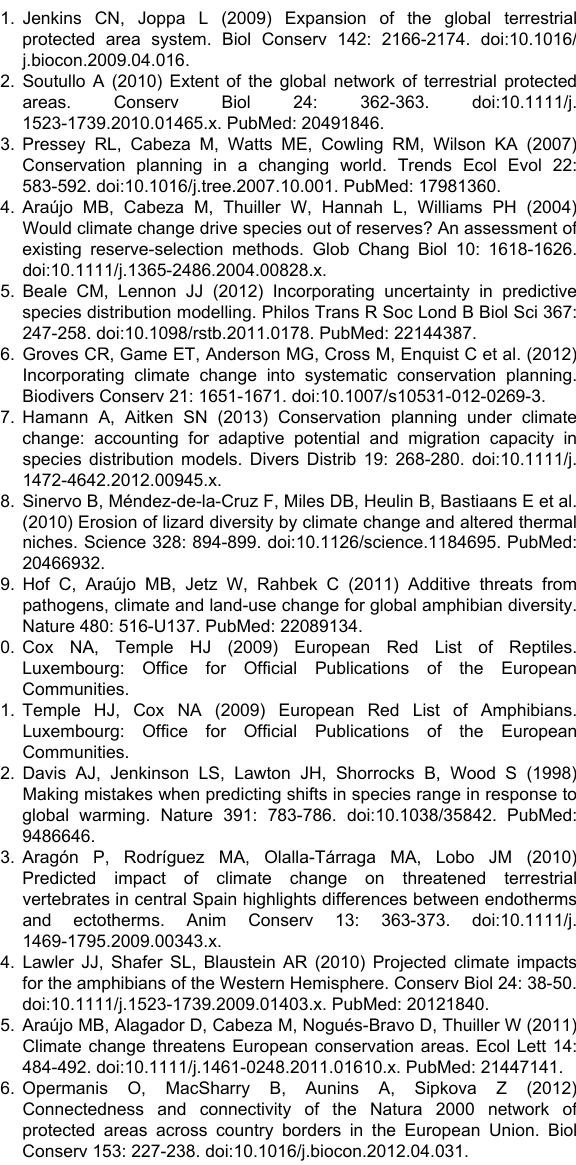
Figure S2. Future irreplaceability scores for emission scenarios A1B (a) and B2A (b) under constrained (left panels) and unconstrained (right panels) planning unit availability for the 2020s and 2050s time horizons and three emission scenarios, under limited (LimD) and no dispersal (NoD)